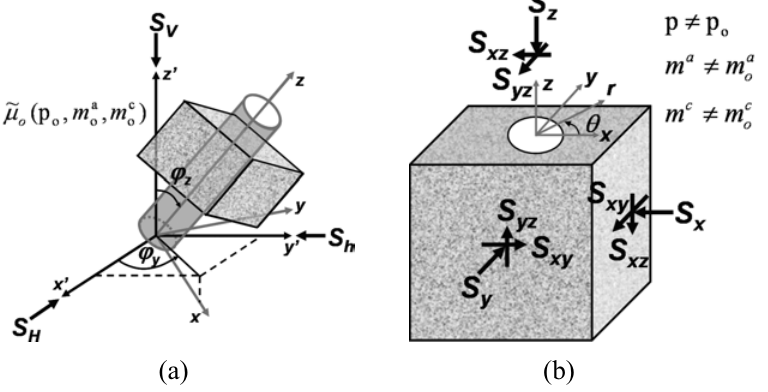
Fig. 1 – (a) Schematic of an inclined wellbore; (b) Far-field stresses, pore pressure and ion concentrations in the xyz local wellbore coordinate